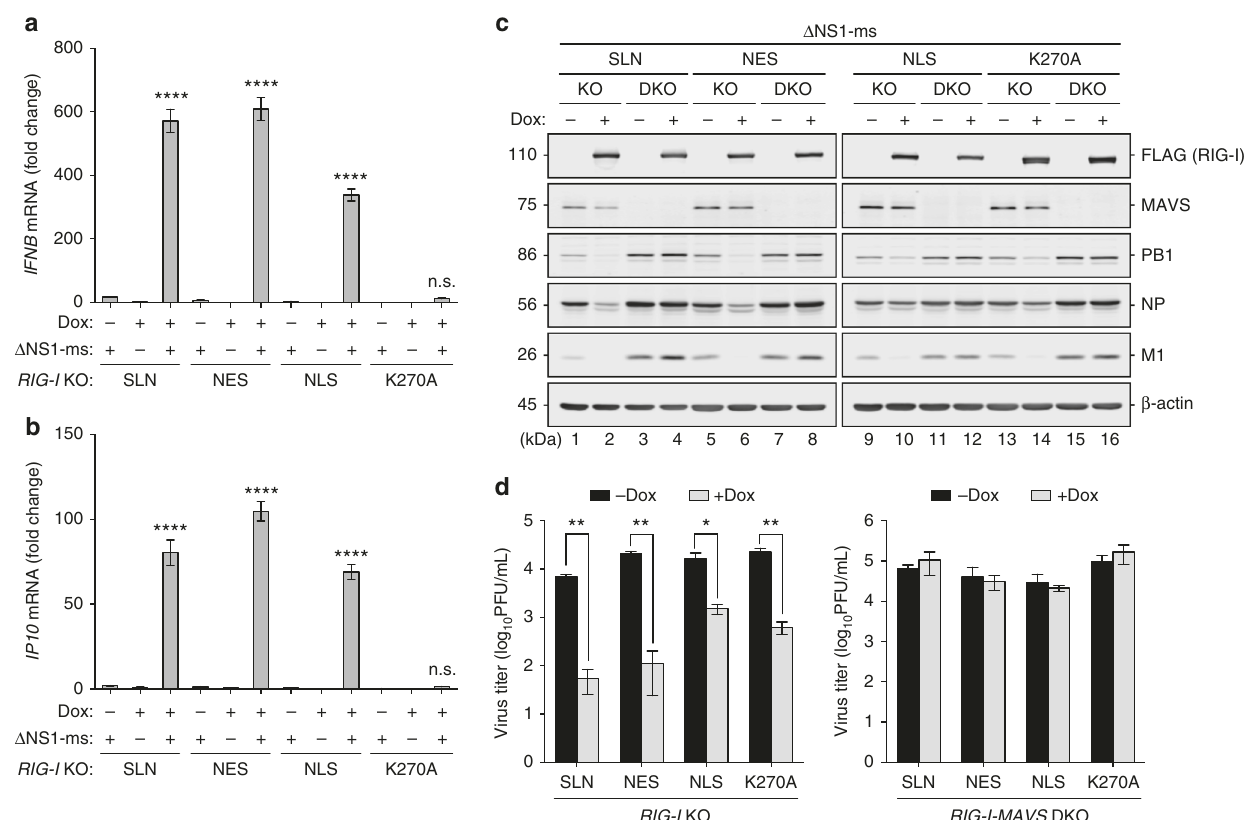
Fig. 5 Nuclear RIG-I restricts IAV infection. a , b A549 RIG-I KO cell lines inducibly expressing SLN-RIG-I, NES-RIG-I, NLS-RIG-I, or K270A-RIG-I were induced with 1 μ g/mL Dox for 4 h, followed by infection with Δ NS1-ms (MOI = 1) for 14 h. The mRNA levels of IFN β and IP10 (CXCL10) were determined by qRT-PCR. Relative mRNA expression was normalized to GAPDH mRNA levels and expressed using the ΔΔ Ct method relative to the SLN (with Dox but without infection) condition. c Inducible A549 RIG-I KO or RIG-I-MAVS DKO cell lines were induced as in a and b , and infected with Δ NS1-ms (MOI = 0.1) for 24 h. Expression levels of FLAG-RIG-I, MAVS, PB1, NP, and M1 were monitored by immunoblotting. d Virus titers in the culture supernatants from c were determined by plaque assay in MDCK-NS1 cells. Data are mean ± SD of three independent experiments. Signi fi cant differences were determined by one-way ANOVA followed by Tukey post-test ( a , b ) or an unpaired Student ’ s t -test ( d ). * p < 0.05, ** p < 0.01, **** p < 0.0001; n.s. not signi fi (Fig. 4a), RIG-I KO A549 cell lines complemented with the compartment-speci fi c or signaling-inactive RIG-I were infected with SeV and probed for IRF3 nuclear translocation. At 8 h.p.i, while SeV stimulated IRF3 activation in SLN-RIG-I and NES- RIG-I-expressing cells, cells expressing NLS-RIG-I did not respond to SeV replication, resembling that in K270A-RIG-I- expressing cells (Fig. 6a). This null responsiveness by NLS-RIG-I to SeV was further con fi rmed by quantifying the percentage of cells with the IRF3 nuclear translocation at the single-cell level (Fig. 6b), and IRF3 phosphorylation across the infected cell population (Fig. 6c). At physiologically comparable levels, NLS- RIG-I also failed to sense SeV replication, whereas it ef fi ciently induced antiviral gene expression in response to IAV infection (Supplementary Fig. 7d – g). Together with the ef fi cient IRF3 activation upon IAV replication (Fig. 4a), these results demon- strated a compartment-speci fi c functional sensing by nuclear RIG-I of nuclear-replicating, but not cytoplasmic-replicating, virus.